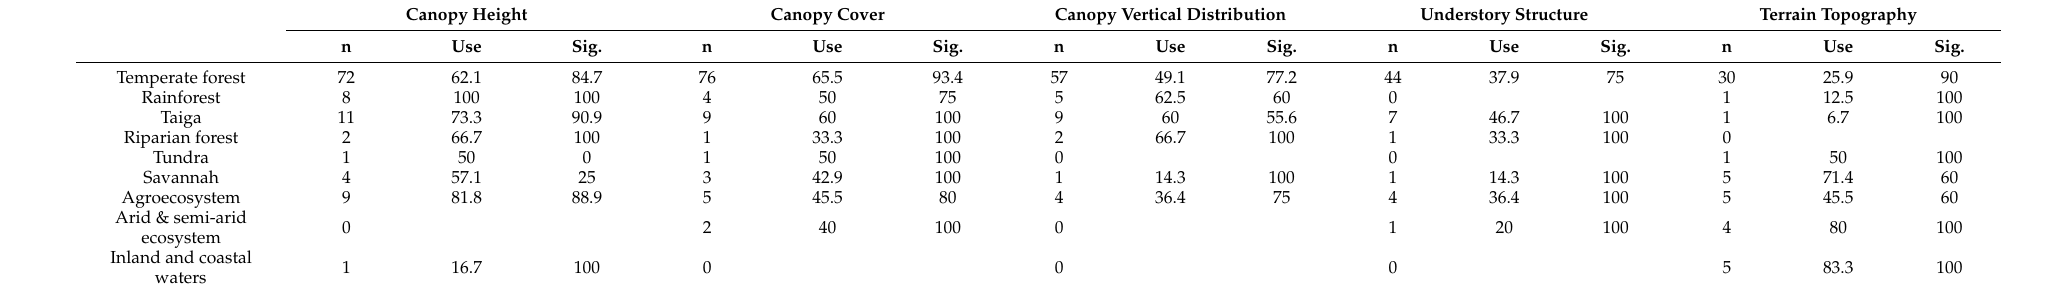
Table 3. Categorized LiDAR-derived traits based on all metrics found in the literature search regarding vegetation structure and terrain topography, and in relation to the harmonized ecosystems. “n“, “use”, and “sig.” values are estimated equally as in Table 2 but for the type of